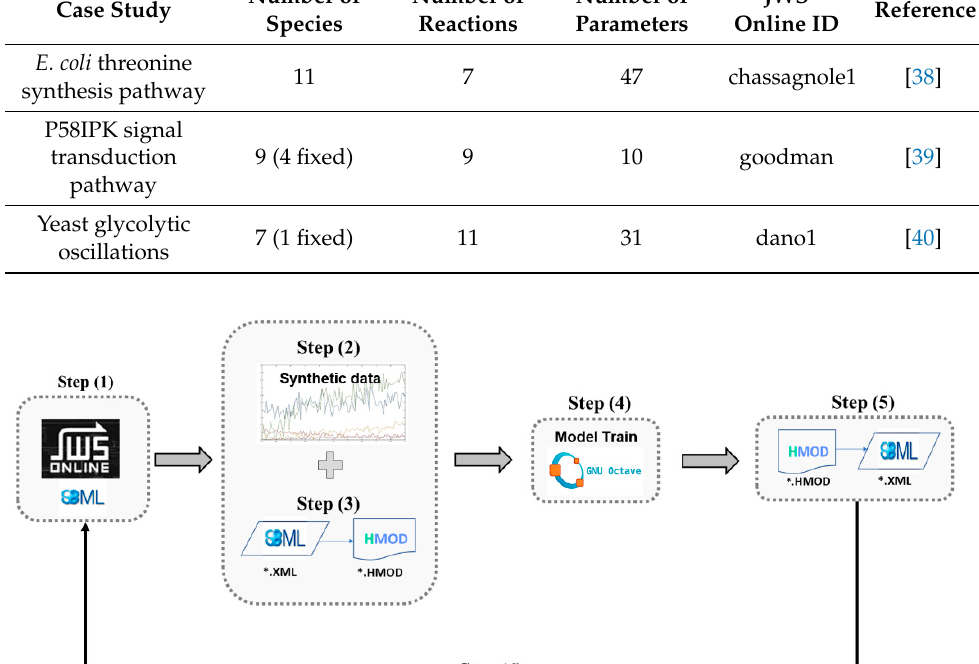
Table 1. Summary of the three SBML models that were redesigned to hybrid mechanistic/neural network models in the present study.